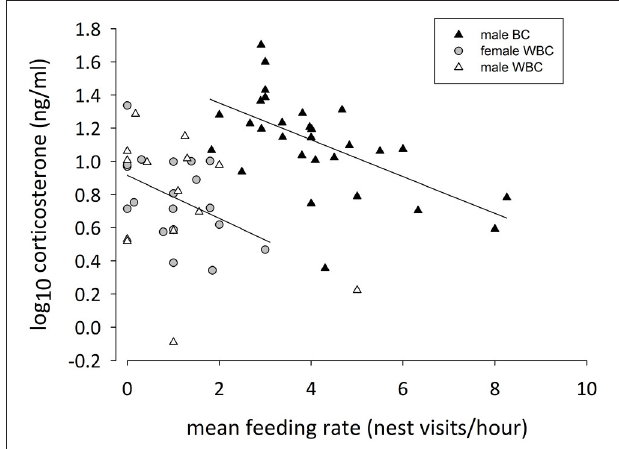
FIGURE 3 | Mean feeding rate and baseline corticosterone concentrations of feeding male black coucals (black triangles), male (white triangles), and female white browed coucals (gray circles). The regression lines refer to male black coucals and female white-browed coucals, only. For male white-browed coucals, there was no relationship between mean feeding rates and baseline corticosterone.